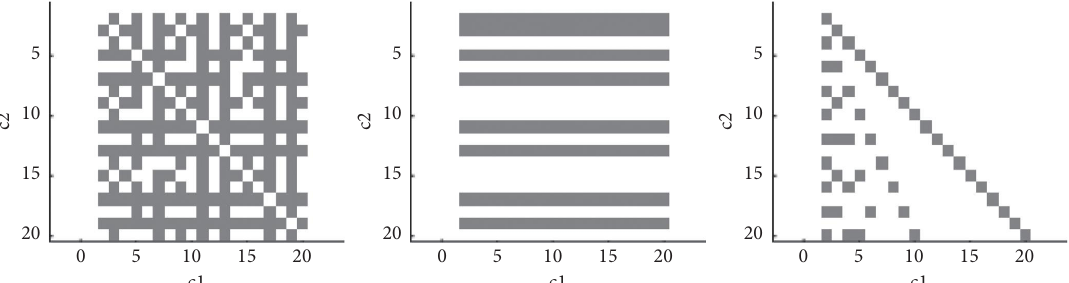
Figure 8: For easier visual reference, here are canonical plots of three typical situations: gray denotes pairs ( c ,c ) � 1, c is prime, or c gcd ( c 1 2 2